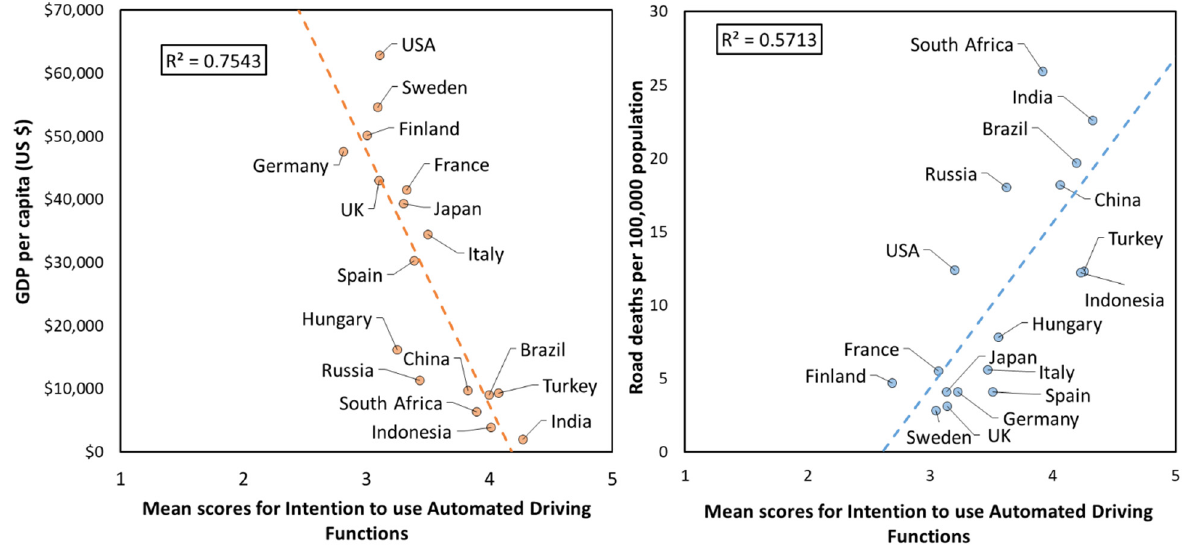
Figure 1. Correlation between 17 countries’ overall mean scores for intention to use Automated Driving Functions (ADFs) (combined) and their respective GDP per capita ( left ), and estimated road deaths per 100,000 population ( right [33]).